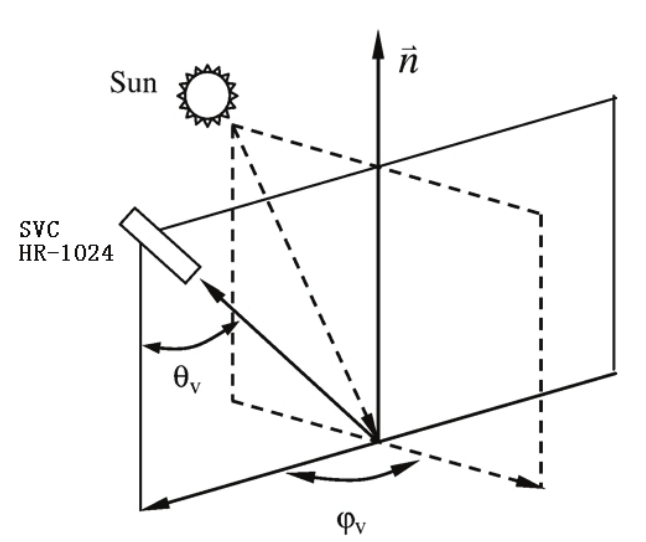
Figure 2. Viewing geometry of spectra